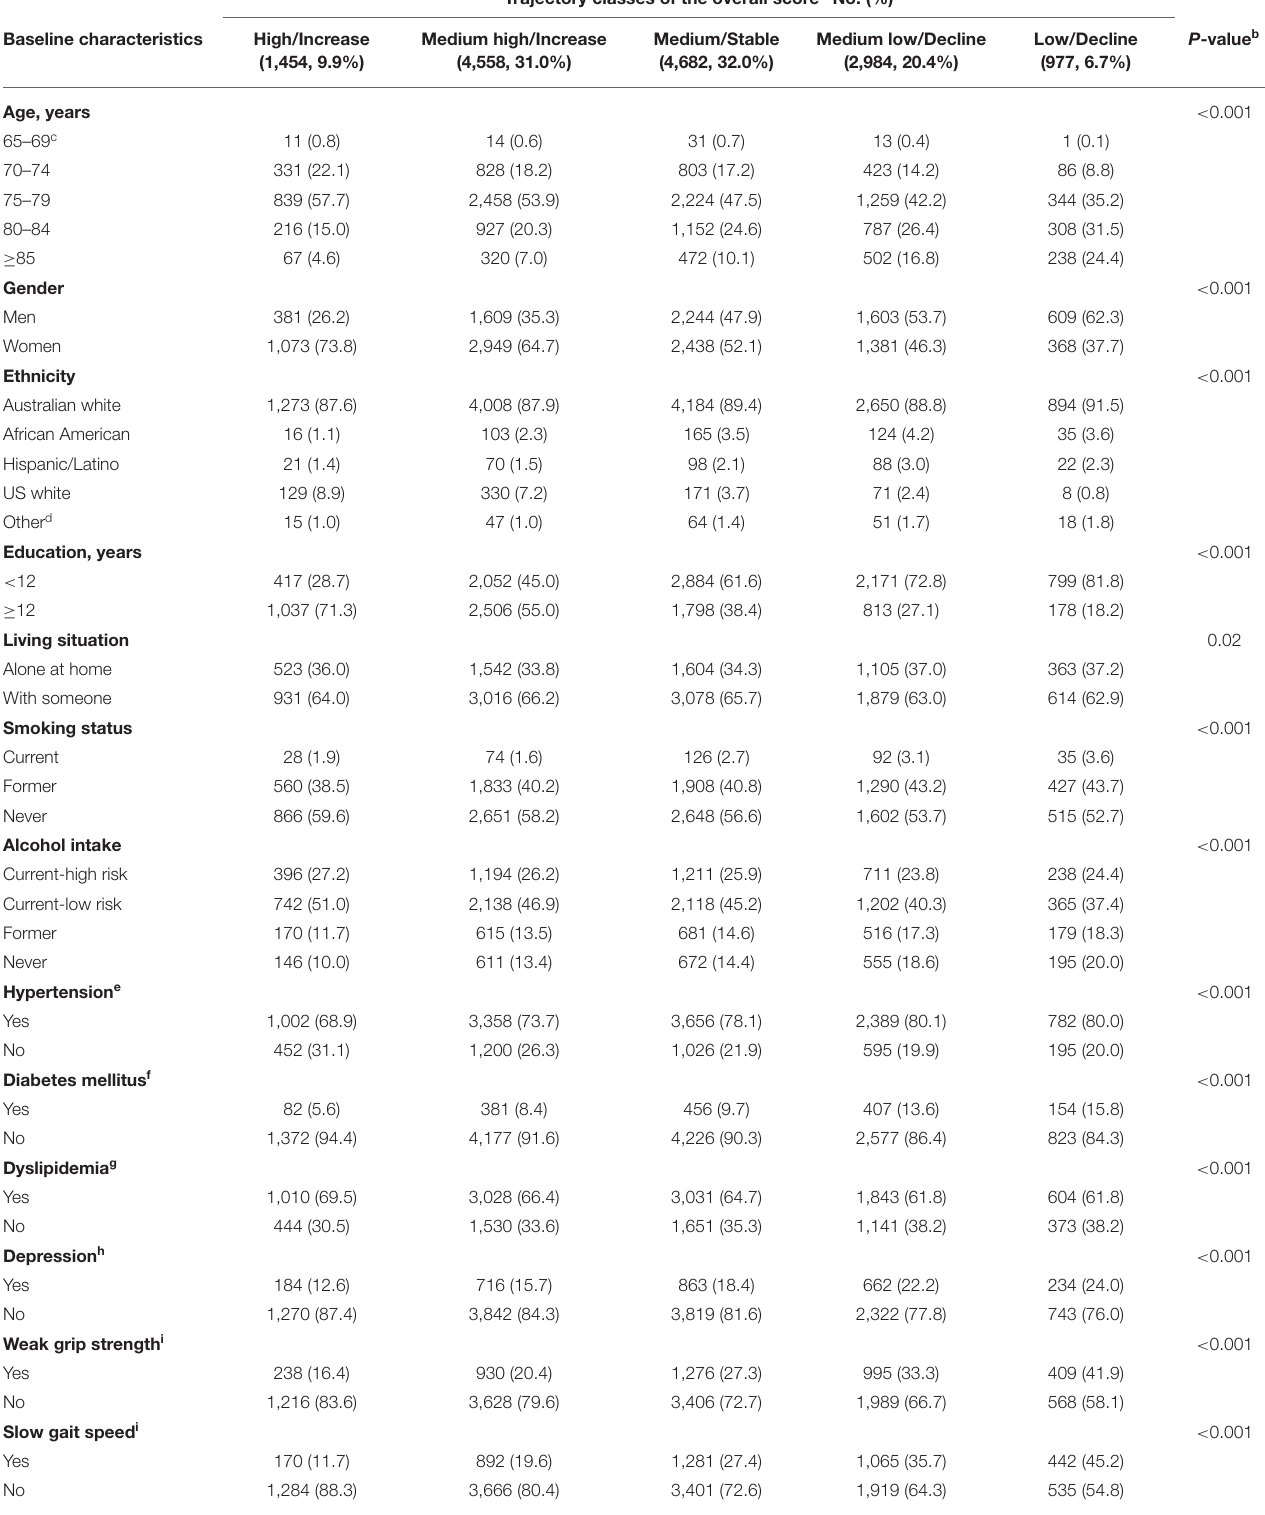
TABLE 1 | Basic characteristics of included participants at their last attended follow-up visit ( n = 14,655). Trajectory classes of the overall score a No.